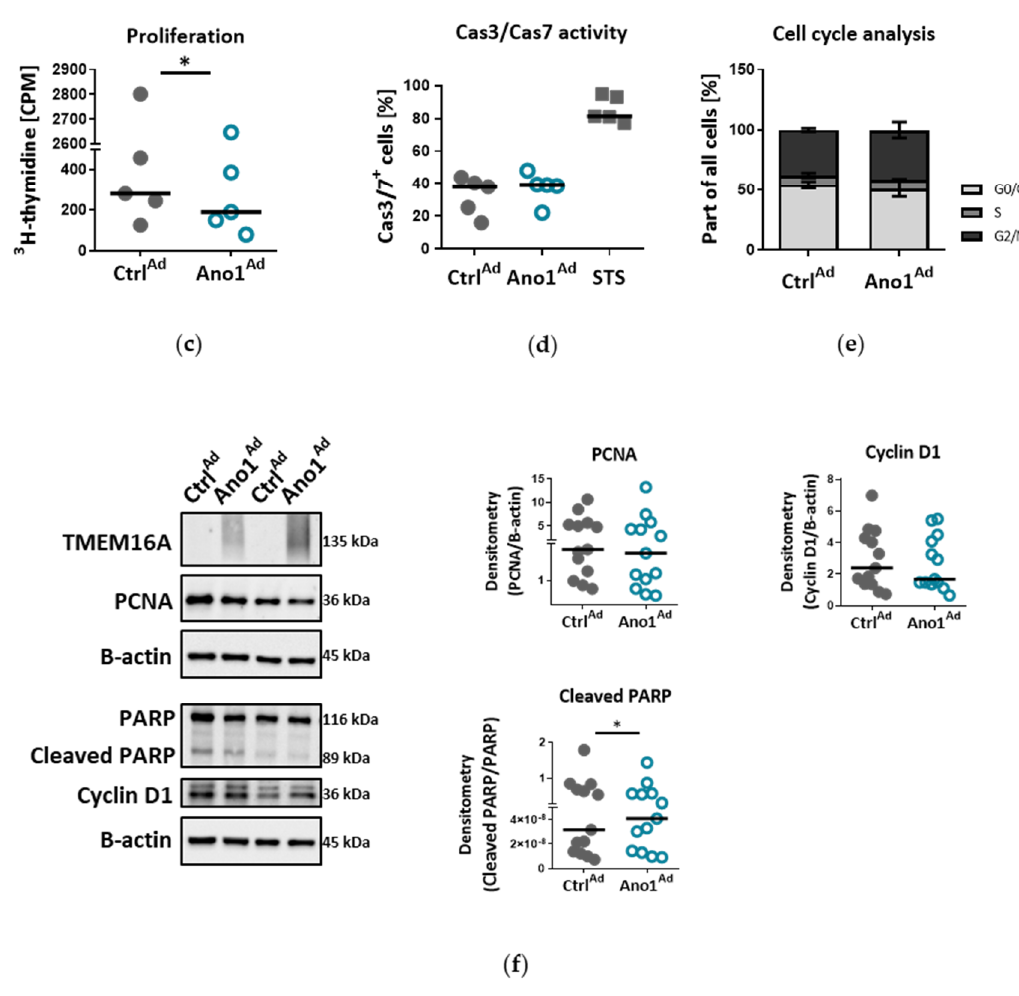
Figure 5. Enhanced TMEM16A mediates metabolic changes of PAECs. ( a – b ) Seahorse mitochondrial stress test profiles of TMEM16A-overexpressing primary PAECs showing the ratio of oxygen consumption rate (OCR) to extracellular acidification rate (ECAR) OCR / ECAR. ( c ) Proliferation of human PAECs overexpressing TMEM16A measured with thymidine incorporation ( n = 5). ( d – e ) Cas3 / Cas7 apoptosis assay and cell-cycle analysis of human PAECs overexpressing TMEM16A. (STS = staurosporin). ( f ) Western blots of PAECs infected with TMEM16A-overexpressing Ano1 Ad or control Ctrl Ad with quantifications of PCNA, cleaved PARP / PARP and Cyclin D1. Figures were generated with 13 separate sets of experiments. * p < 0.05, ratio-paired ( a ) or paired t-test.